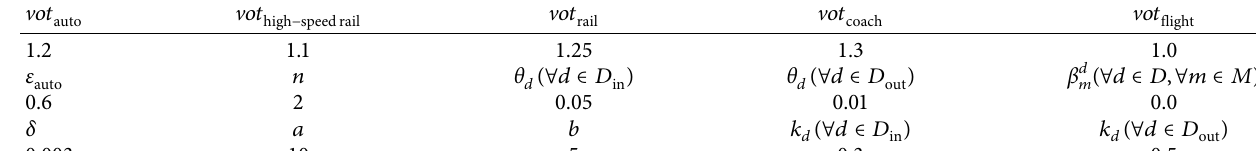
Table 3: Parameters for nested logit model-based traffic assignment.